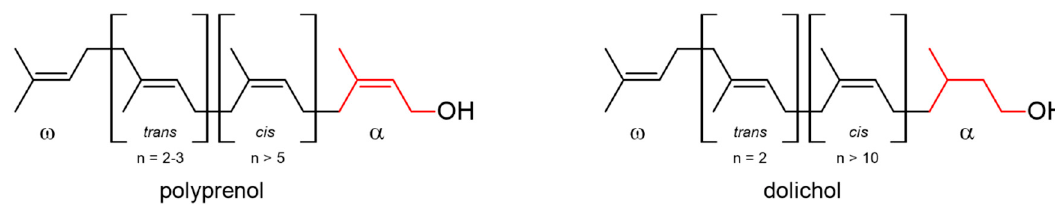
Figure 1. Structure of polyprenol and dolichol. α and ω represent terminal isoprene units. The internal isoprene residues in trans and cis configuration are indicated.